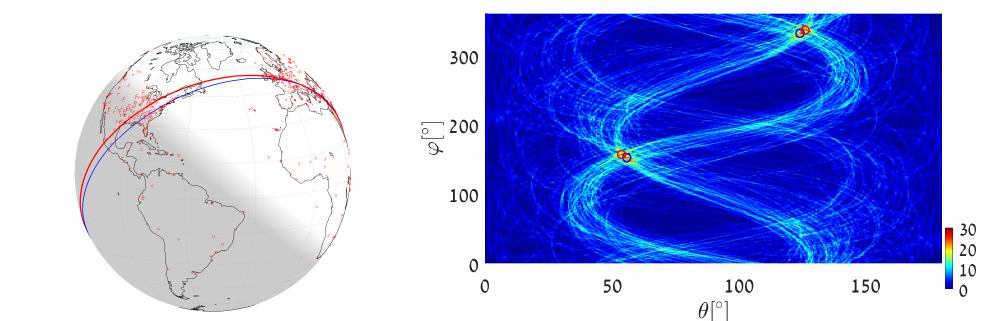
Figure 20. Executing Algorithm 3 on the airport database: ( Left ) The blue great circle passes through the maximum number of airports (red dots). The red great circle corresponds to the second maxi- mum, following the unvoting process. ( Right ) Heat plot of the accumulator array M , showing the parameters of the two great circles.